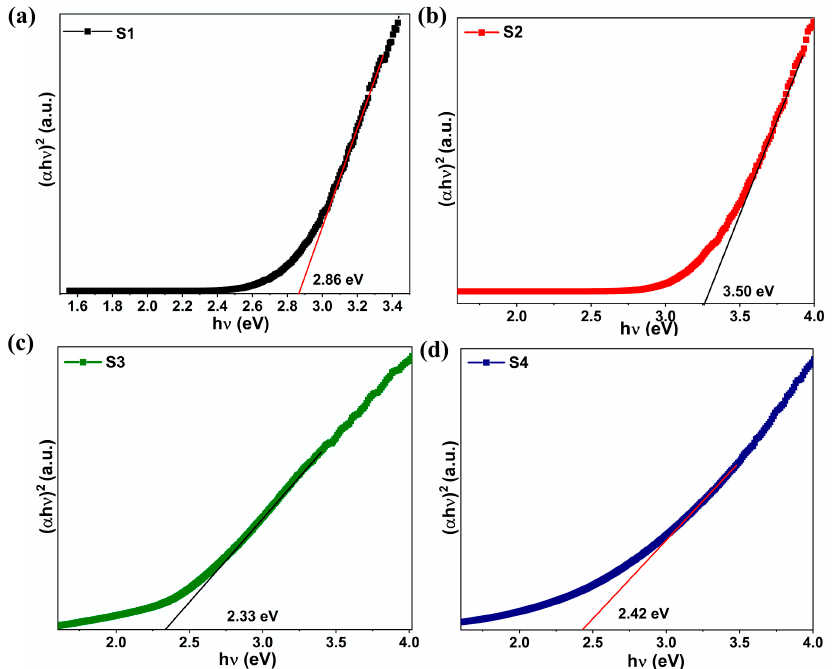
Figure 4. Tauc plot of SnS 2 nanoparticles synthesized in the absence and presence of capping agent by thermal decomposition method.